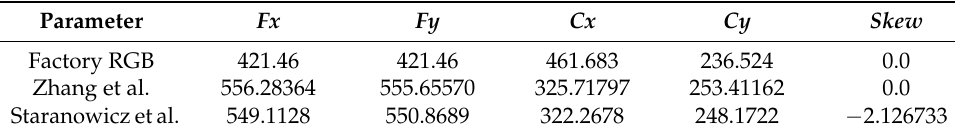
Table 2. Color camera (RGB) intrinsics parameters.